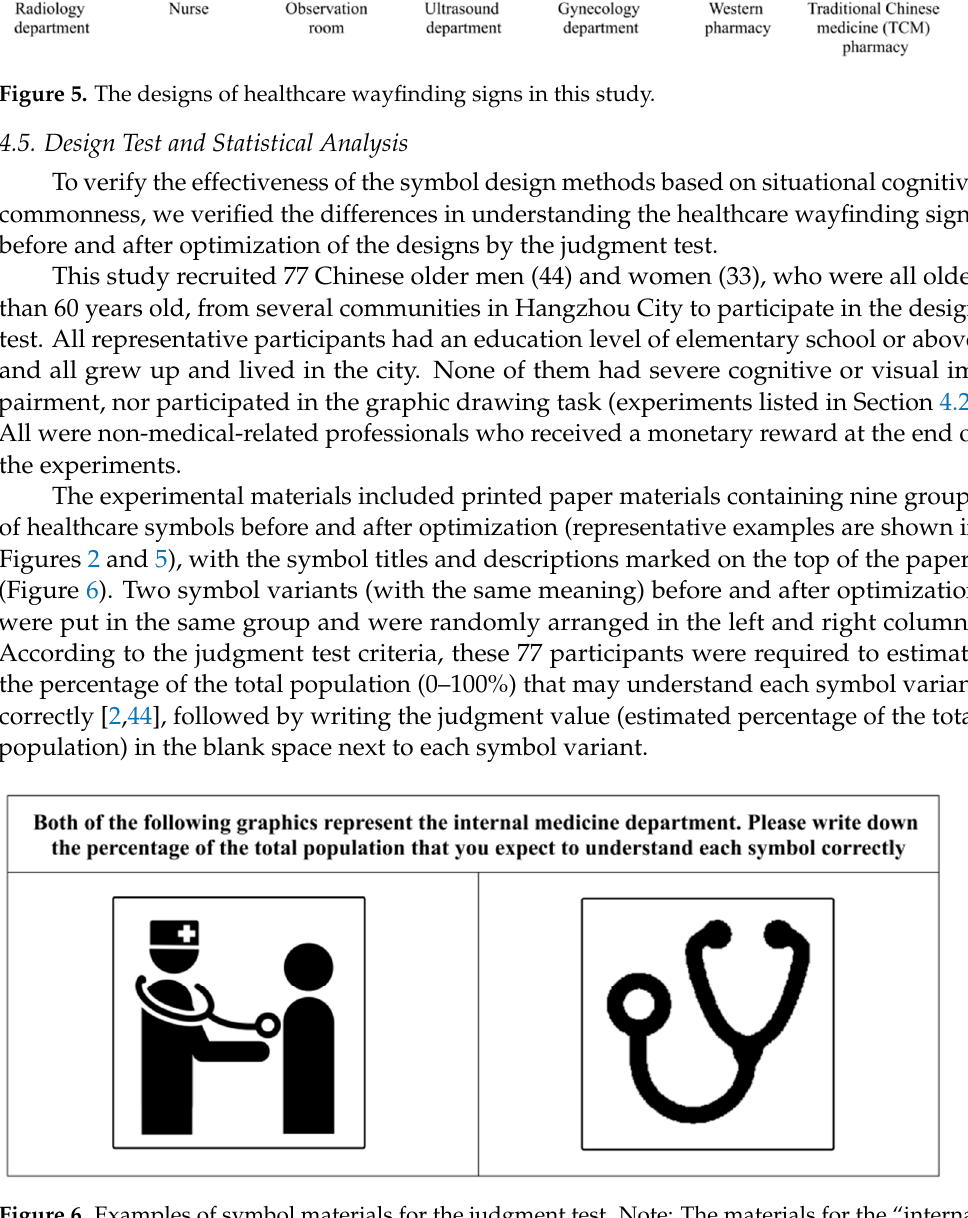
Figure 6. Examples of symbol materials for the judgment test. Note: The materials for the “internal medicine department” here are taken as examples.